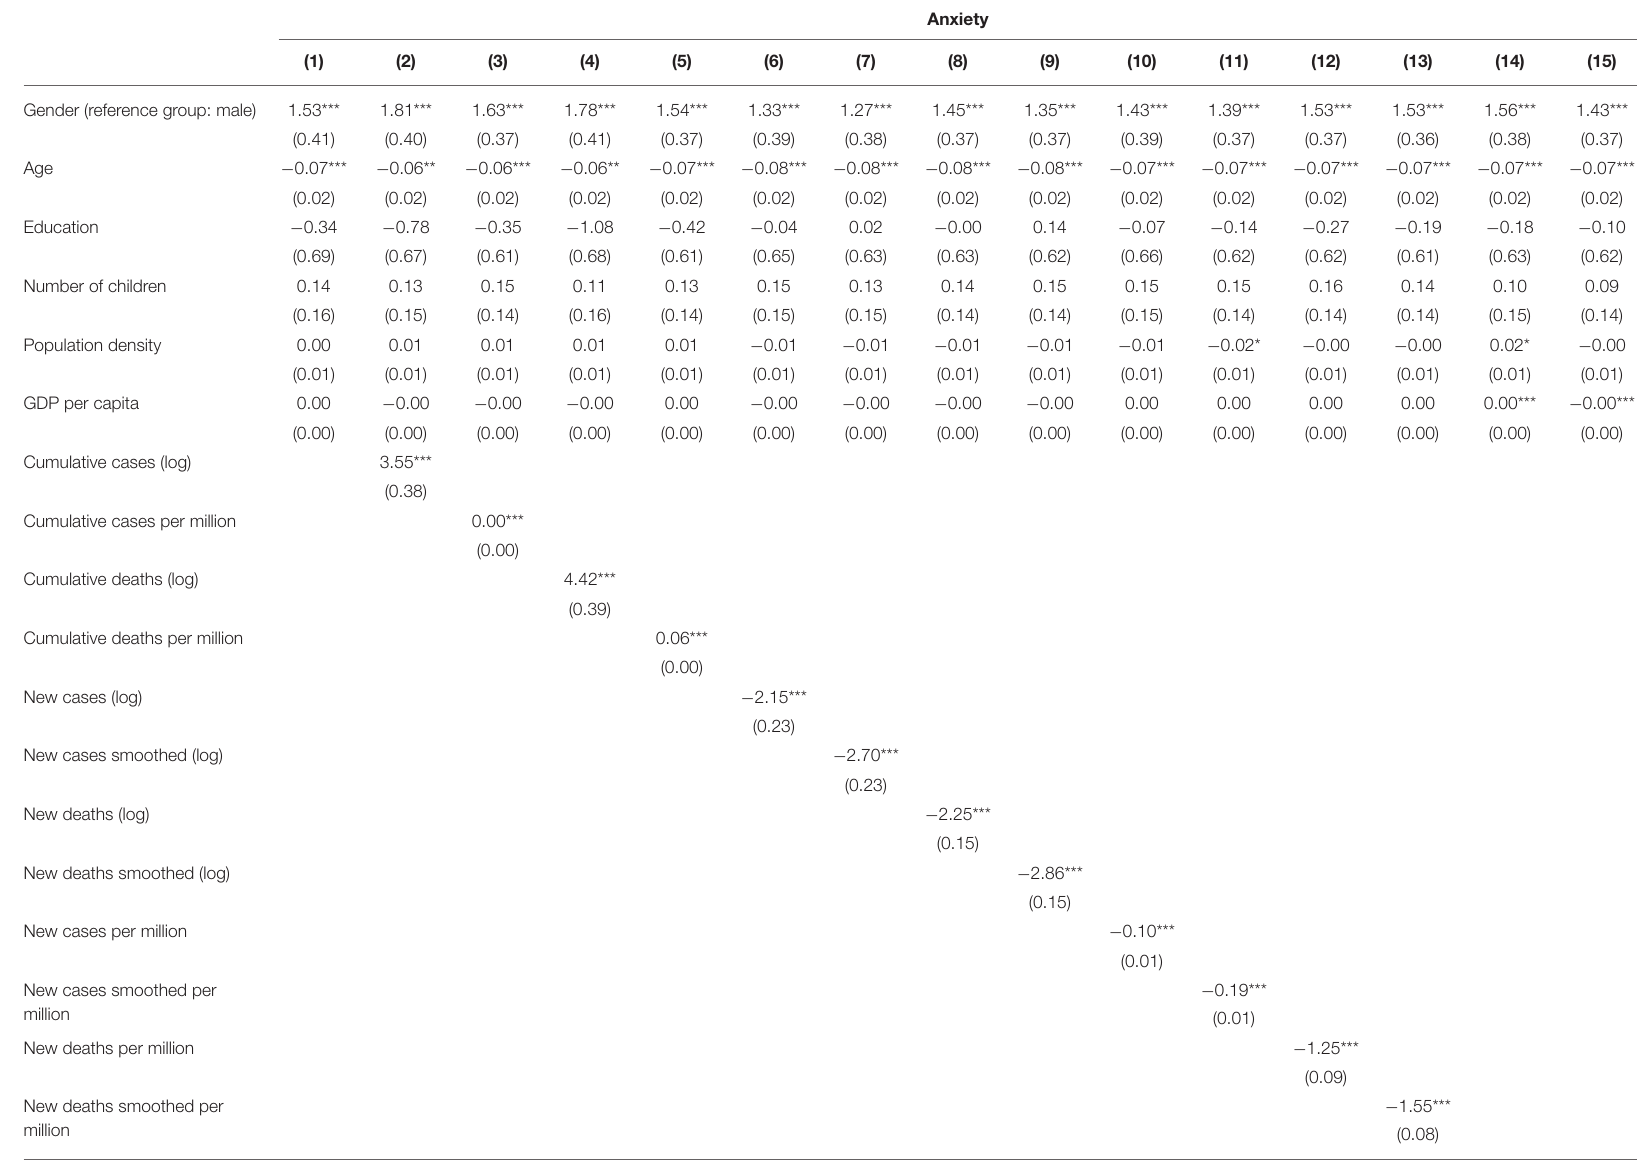
TABLE 5 | Predictors of managers’ anxiety symptoms in ordinary least squares regression ( n = 812, N =